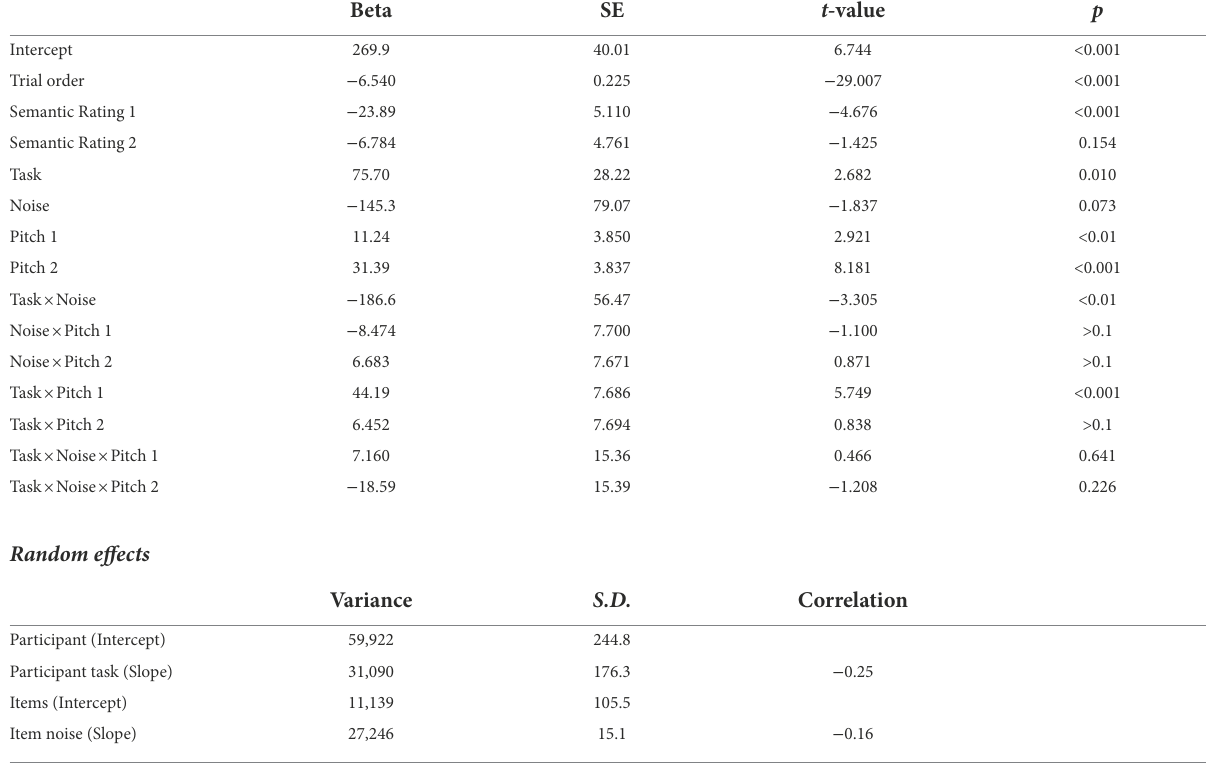
TABLE 2 Final model for the effect of noise and task on peak pupil